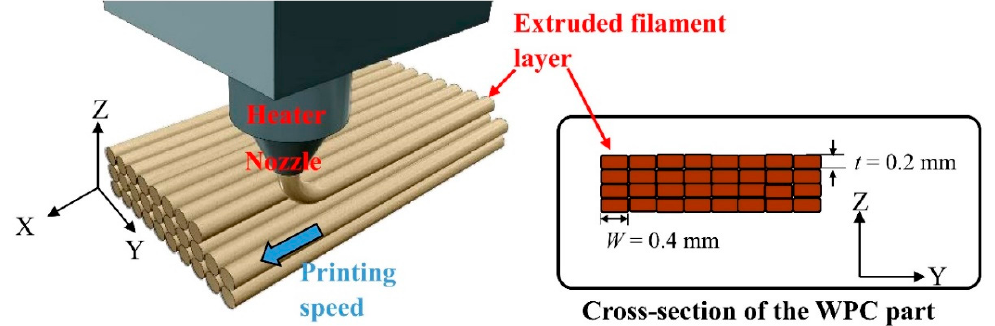
Figure 1. Schematic of a customized FDM system and the cross-section of the WPC part printed with extruded filament layers.